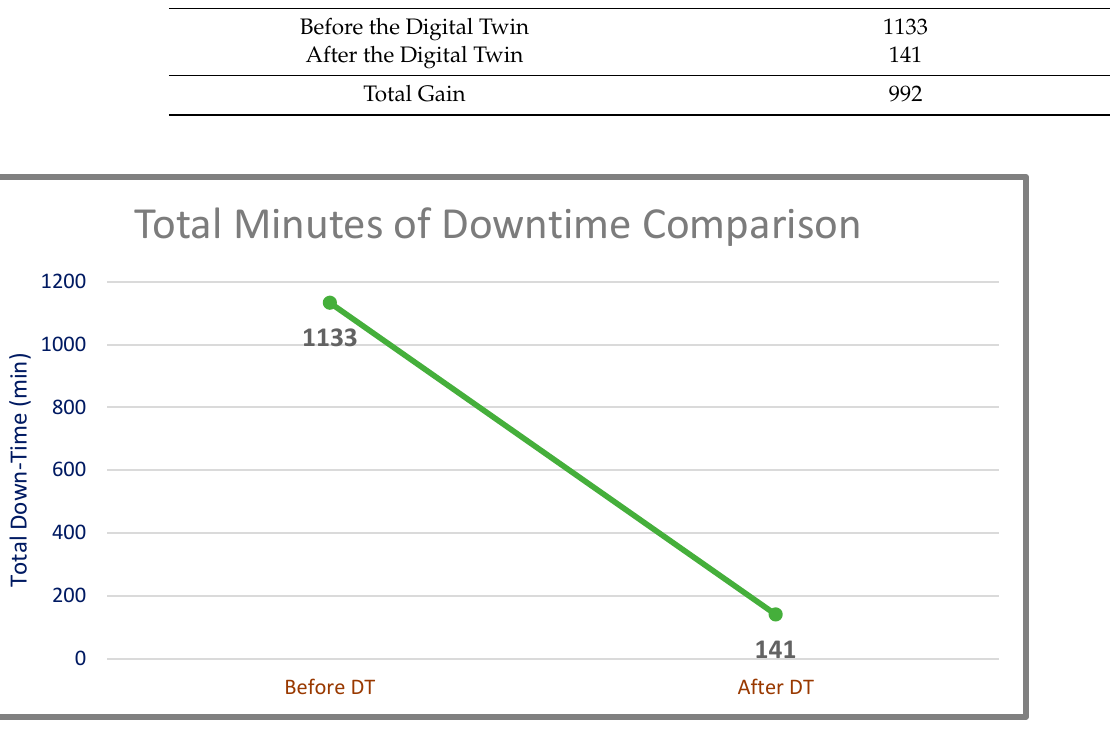
Table 5. Daily working time required to do the same amount of work before using the DT.